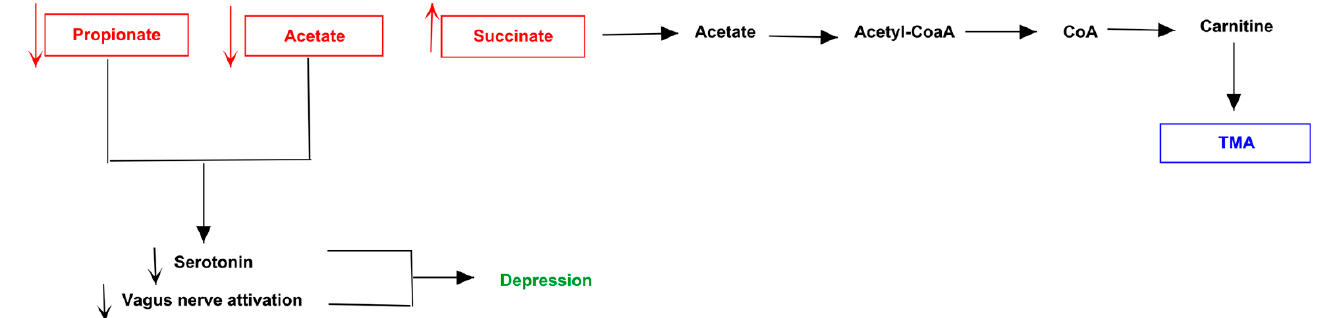
Figure 12. Biochemical pictures of TMAU patient 7. The panel represents how metabolites produced directly or indirectly by patient’s microbiota could influence the biosynthesis/release of neurotransmitters (in particular serotonin) and the production/accumulation of